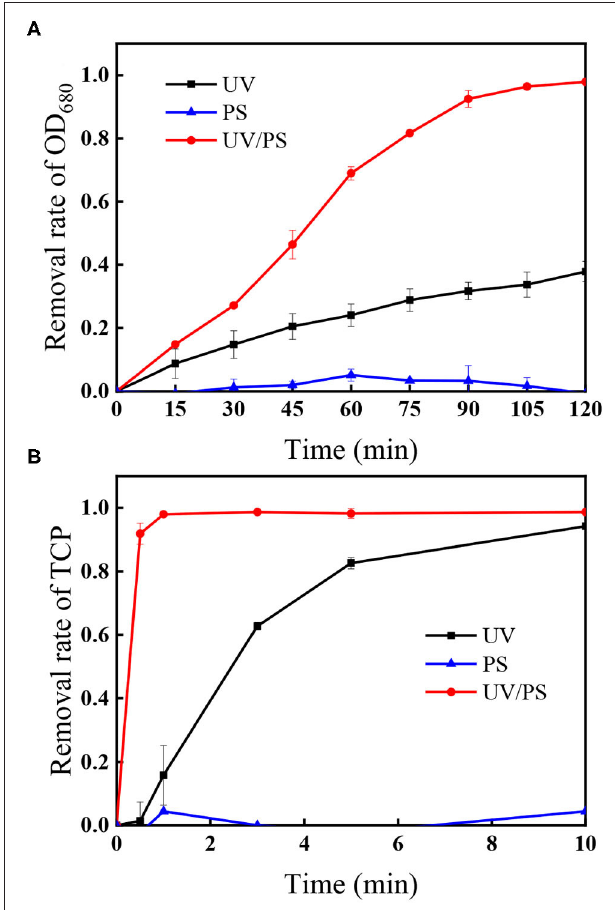
FIGURE 1 | The removal of (A) OD 680 and (B) TCP under different treatment processes. Conditions: initial algal cell density: (1.00 ± 0.05) × 10 6 cells/mL, initial TCP concentration: 20 µ M, initial pH: 7.6 ± 0.2, temperature: 25 ± 1 ◦ C, UV intensity: 7.82 mW/cm 2 , PS dose: 4.5mM. The error bars represent the standard deviations from duplicate